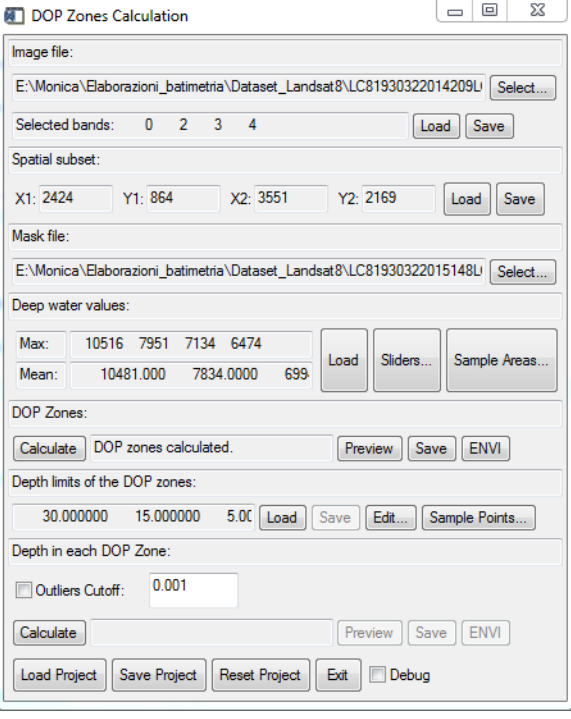
Figure 2. Main program